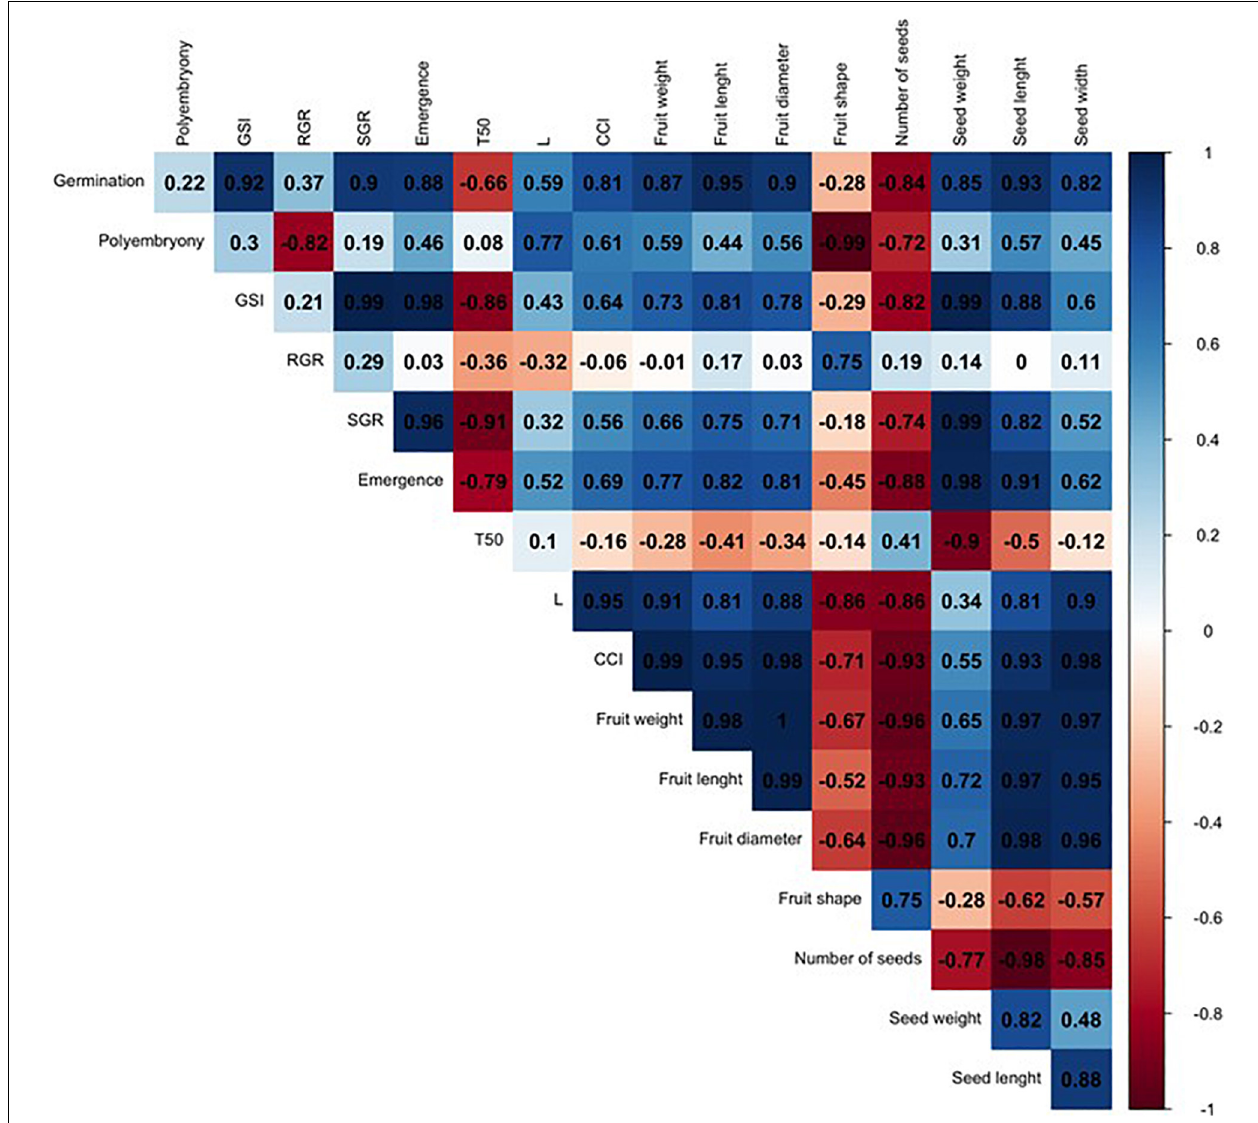
FIGURE 8 | Correlation analysis among the variables studied for US-942 rootstock. The numbers display the Pearson’s correlation coefficient (r). Blue cells indicate positive correlations among the variables (1) and the red cells indicate negative correlations (–1). The color density and numbers reflect the scale of correlation. Variables: germination; polyembryony; GSI: germination speed index; RGR: root growth rate; SGR: shoot growth rate; emergence; T50: days to reach 50% of the total emergence; L : lightness value; CCI: citrus color index; fruit weight; fruit length; fruit diameter; fruit shape; number of seeds per fruit, seed weight; seed length; and seed